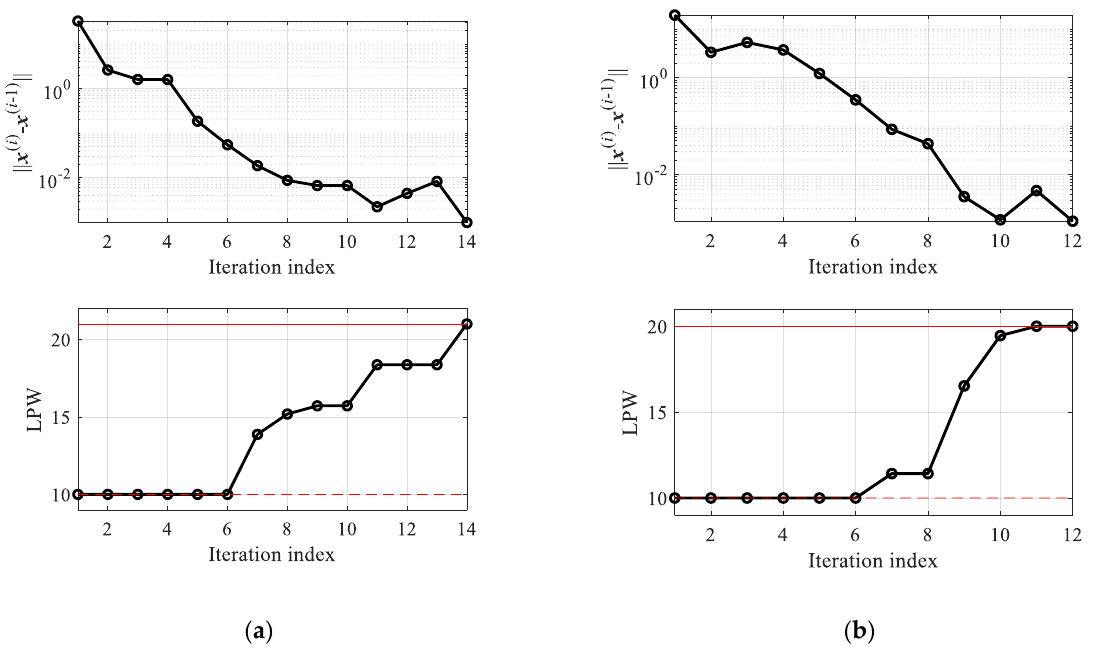
Figure 8. Convergence plots (top) and the evolution of antenna discretization density (bottom) in terms of lines-per-wavelength (LPW) parameters in typical runs of the proposed algorithm for ( a ) Antenna I, ( b ) Antenna II. Horizontal lines correspond to the lowest fidelity L min (- - -), and the high-fidelity model L max ( — ).